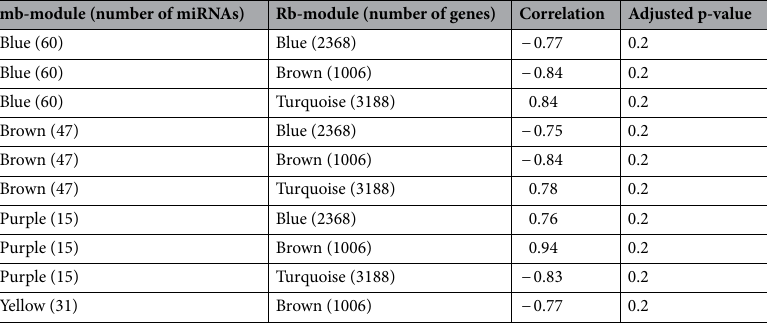
Table 1. Results of assignment of the mb-modules to the non-preserved